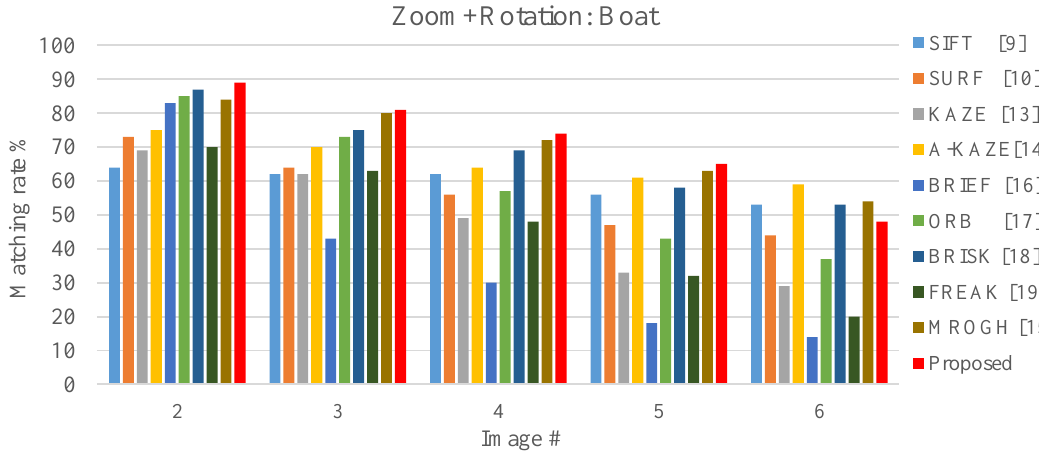
Figure 21. Local stable feature matching outcomes under various scales and rotation angles.